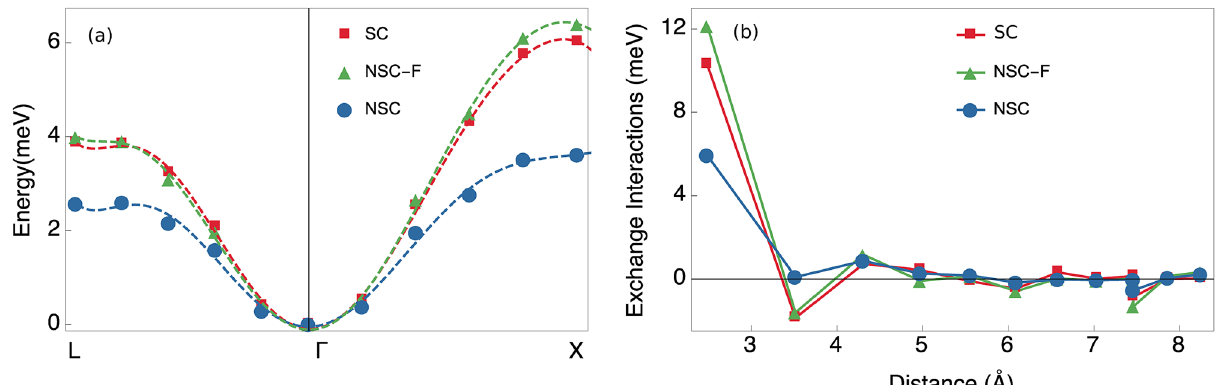
Figure 3. ( a ) Spin-spiral energy dispersion in fcc Ni. The blue circles and green triangles represent non- self-consistent total energies calculated without- (blue) and with (green) constraining fields. The red squares represent self-consistent total energies. Dashed lines represent fitted polynomials. ( b ) Exchange parameters in fcc Ni. The green triangles and blue circles represent exchange parameters calculated non-self-consistently with- (green) and without (blue) constraining fields. The red squares represent exchange parameters calculated with the transverse field